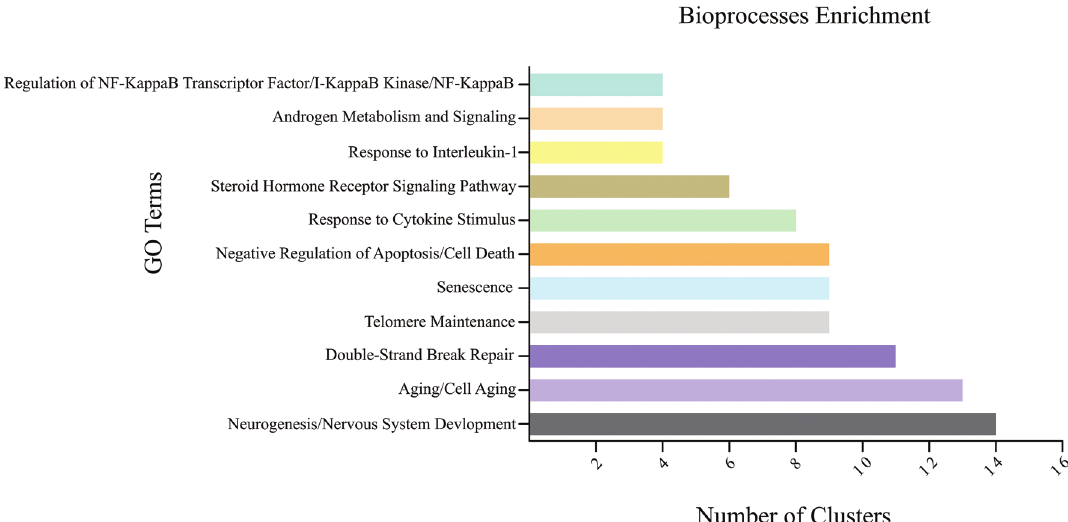
Figure5 -SummaryofthebioprocessenrichmentidentifiedinthePPInetwork.ThecoloredhorizontalbarsshowGOtermsfrequentlypresentintheana- lyzed clusters.